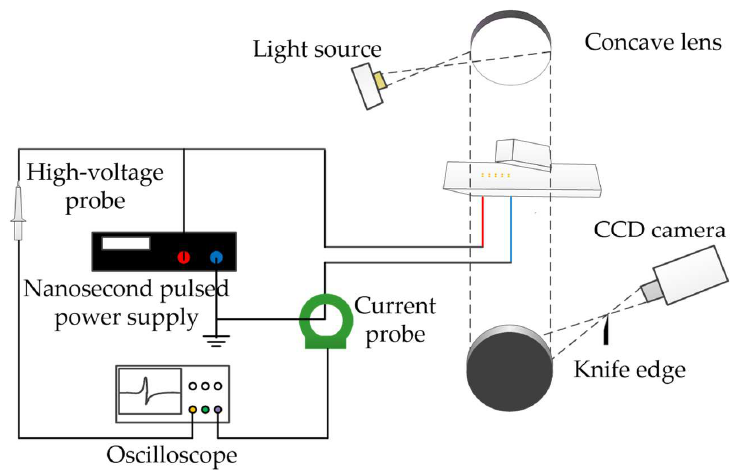
Figure 3. Schematic diagram of plasma actuation system and high-speed schlieren system.